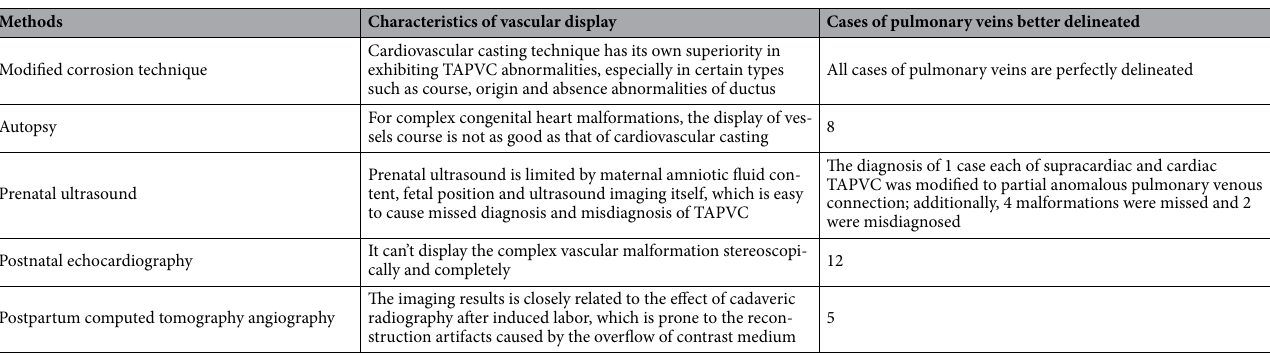
Table 3. Comparing the modified corrosion technique to the currently available fetal imaging methods on